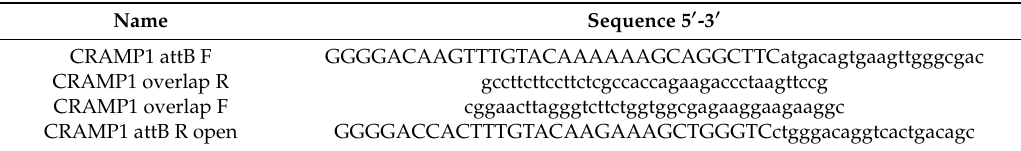
Table 3. Name and sequence of PCR primers used for CRAMP1